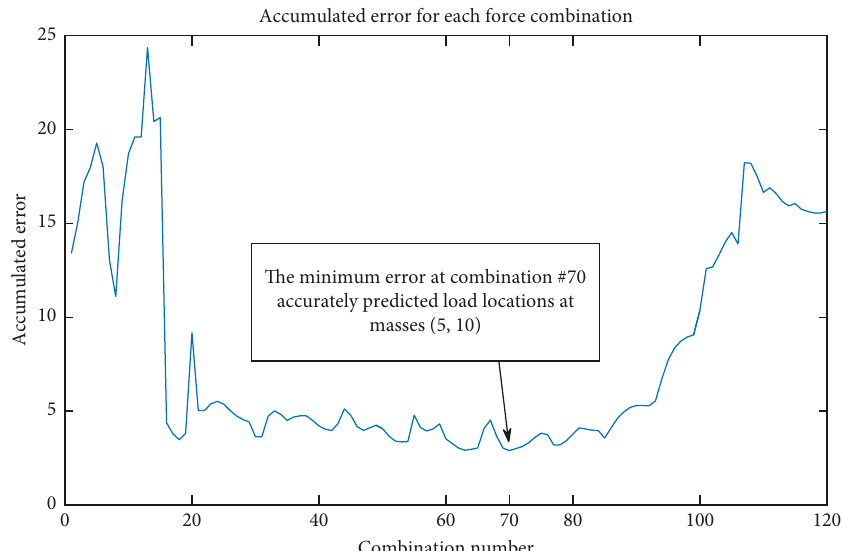
Figure 6: Accumulated error for 5 retained modes using 5 optimum sensor locations.